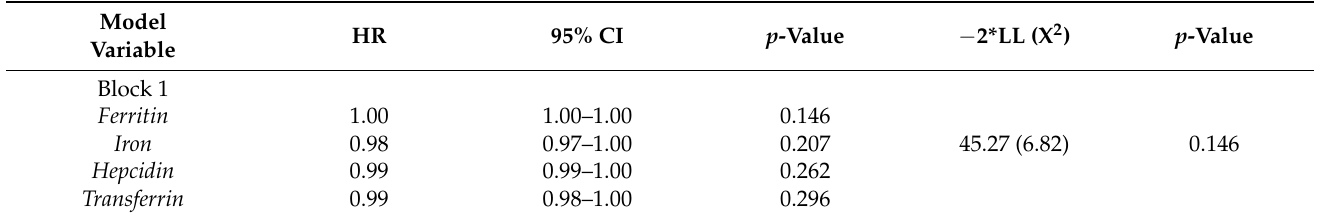
Table 5. Multivariate Cox proportional hazards analysis of different models and comparison with Block 0 or beginning